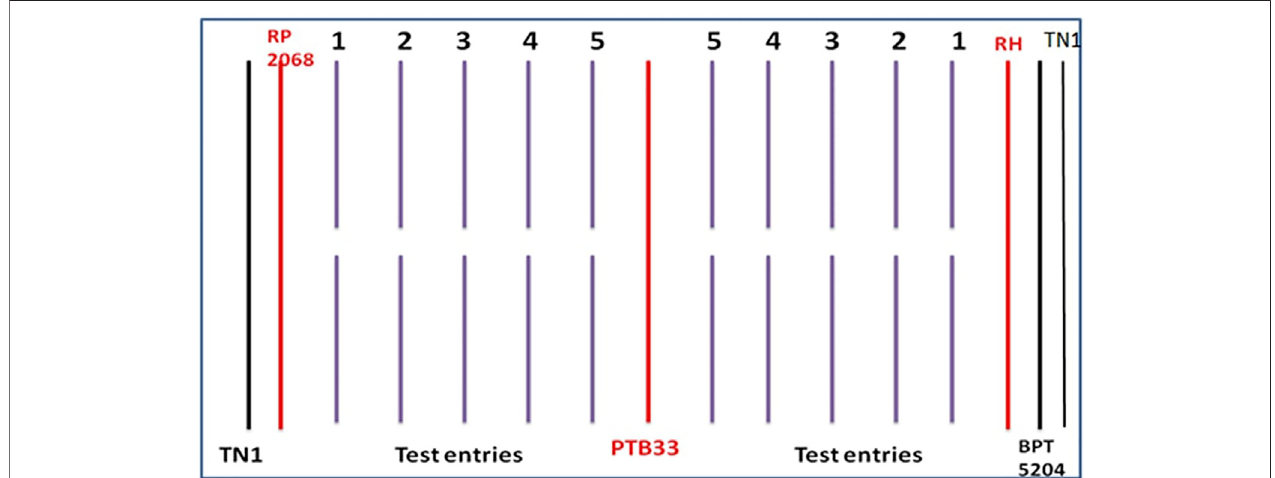
FIGURE 1 | Layout of entries along with resistant and susceptible checks evaluated for BPH resistance using SSST method (RH = RathuHeenati).